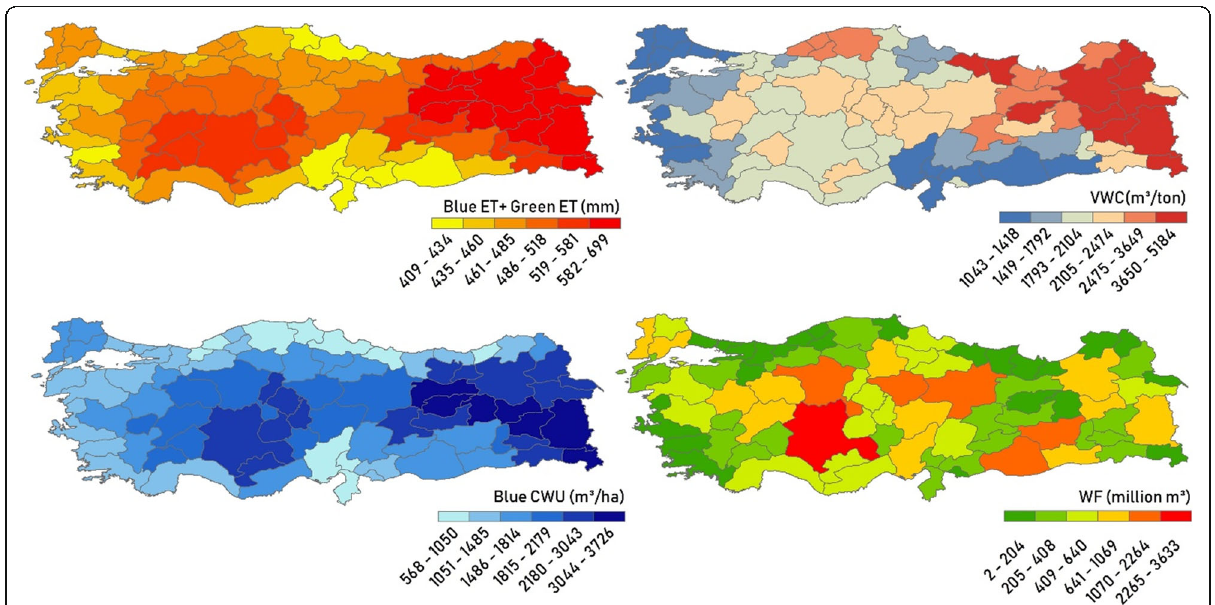
Fig. 5 Wheat ’ s blue and green ET, VWC, blue CWU and WF maps through Turkey ’ s provinces (city names are reported in provincial map, Fig.